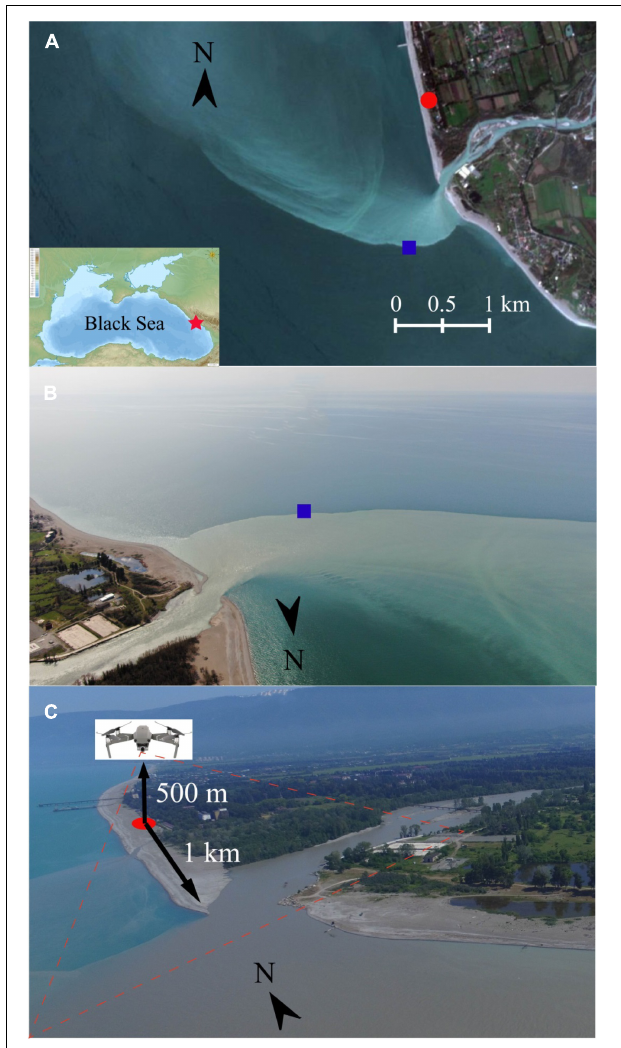
FIGURE 1 | Satellite (A) and aerial (B) images of the Bzyb plume acquired on 15 April 2021 at 11:20 (B) and 11:28 (A) , i.e., almost simultaneously. Scheme of quadcopter observations at the study area (C) . The red circles in the panels (A,C) indicate the place where the quadcopter spot and the meteorological station were located. The blue squares in the panels (A,B) indicate the place of ADCP measurements at the plume border. The red star at the inset in panel (A) indicates the location of the study area at the eastern part of the Black Sea. The dashed red triangle in the panel (C) indicates the quadcopter observation angle. Note that the aerial image shown in the panel (C) was taken during the other day that the almost simultaneous images shown in the panels (A,B)